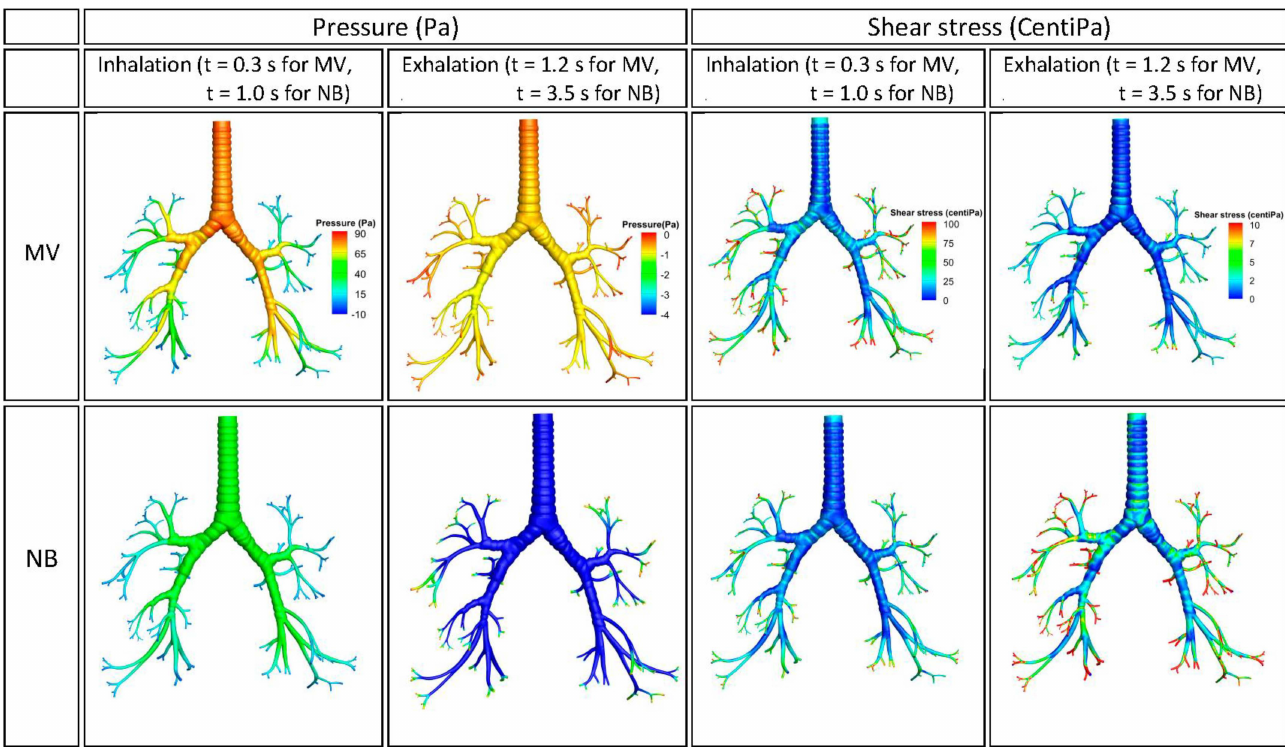
Figure 4. Comparison of airflow of pressure and shear stress for the MV and NB. The comparison was during inhalation (t = 0.3 s for MV, t = 1.0 s for NB) and exhalation (t = 1.2 s for MV, t = 3.5 s for